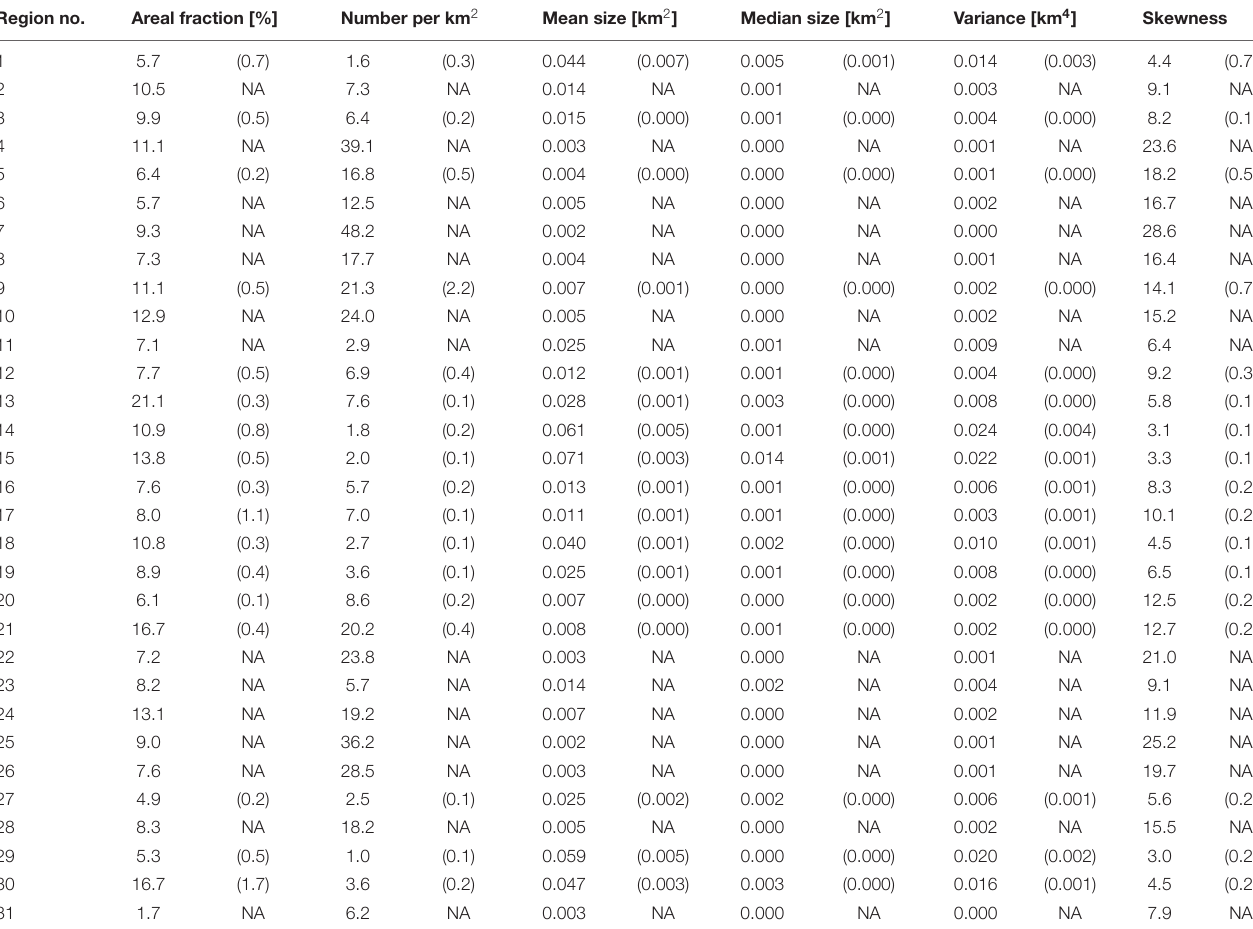
Statistics are calculated for the waterbody size bin between 0.0001 and 1 km 2 . Study areas larger than 300 km 2 were subdivided into 10 × 10 km boxes. Statistics were calculated for each box and then averaged over all boxes within the study region, giving an average value for the entire region. Numbers in brackets show the standard error of the mean of each subgridded statistic. Region no. refers to the study region number in Figure 1 .